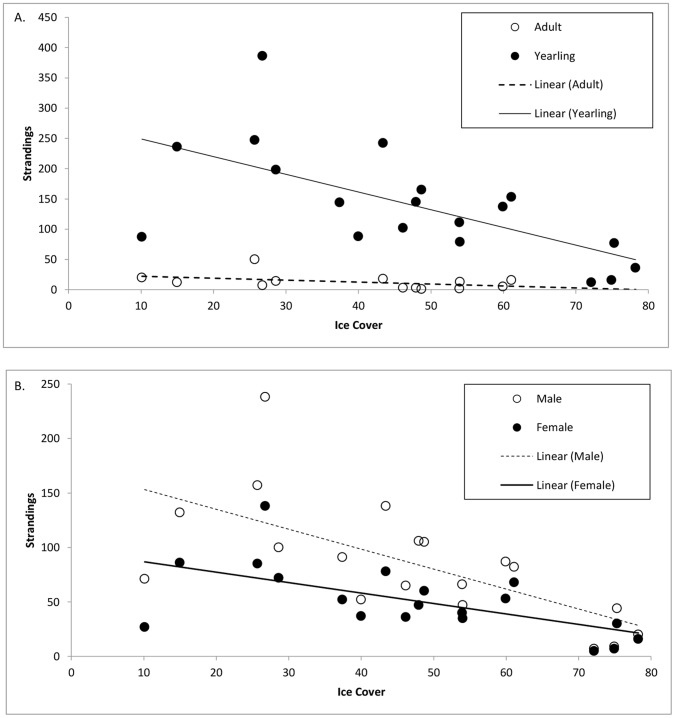
The relationship between percent sea ice cover and yearly strandings based on A.
age class and B. sex. A. The graph represents a linear regression between percent ice cover in February and the number of yearly adult strandings (open circles and dashed line) and yearling strandings (solid dots and line). B. The graph represents a linear regression between percent ice cover in February and the number of yearly male strandings (open circles and dashed line) and female strandings (solid dots and line).